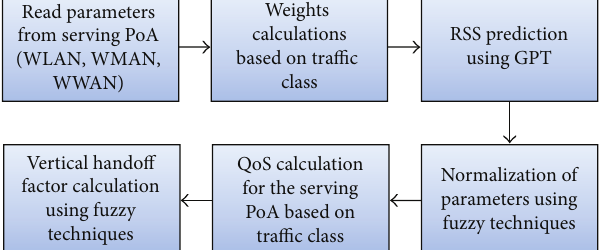
Table 1: Operating ranges of network